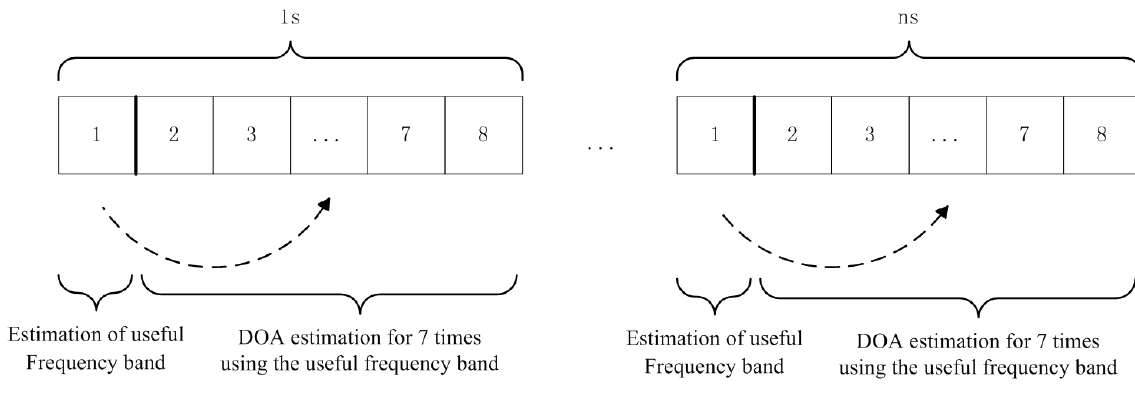
Figure 5. A schematic diagram of direction finding